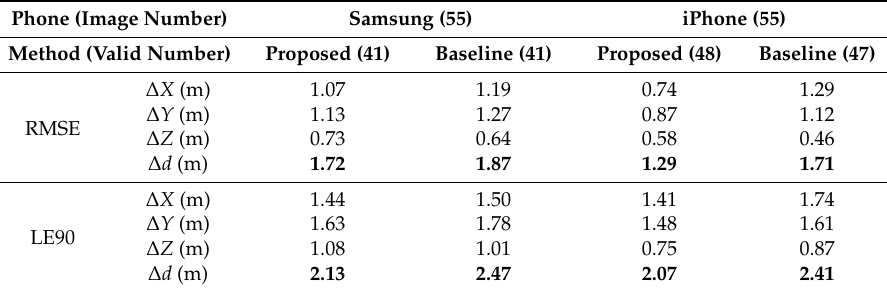
Table 3. Accuracy evaluation of the second